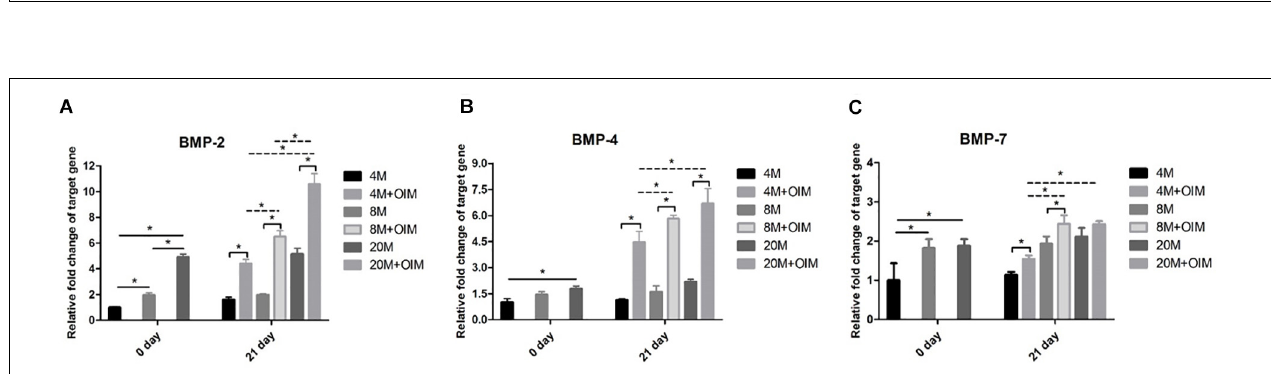
FIGURE 6 | The BMP-2/4/7 expression of TSPCs was increased with aging. The BMP-2/4/7 expression of TSPCs isolated from ossified tendon aged 4, 8, and 20 M. Statistical diagrams show the expression of target genes measured by qRT-PCR, including BMP-2 (A) , BMP-4 (B) , and BMP-7 (C) . ∗ P < 0.05.